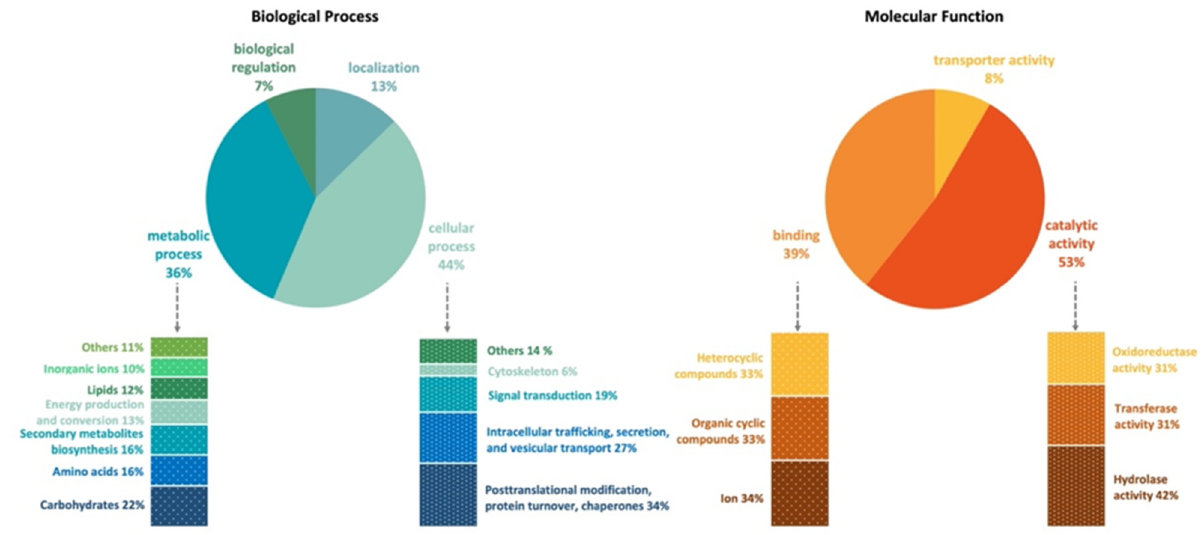
Figure 1. Gene Ontology (GO) functional annotation (pie charts) and EggNOG functional classifica- tion (bars charts) of Emericellopsis cladophorae MUM 19.33 genome. tion (bars charts) of Emericellopsis cladophorae MUM 19.33